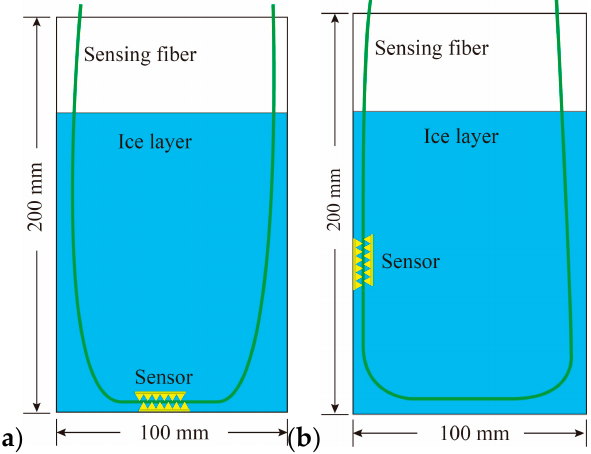
Figure 8. The sensor layout diagram; ( a ) measuring the static ice pressure on the bottom; ( b ) measuring the static ice pressure on the